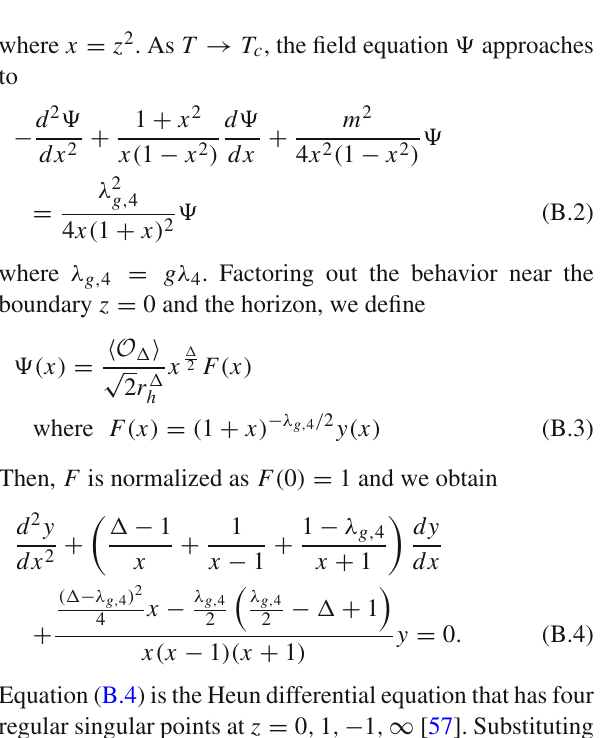
Table 5 ω n and T at lower T ’s. where n = 1 , 2 , 3 ,... . A position of the pole is obtained from Eq. (A.98) with given T T c T c program Poles of σ(ω) ω 1 T = 0 . 1 with ω / T = 10 . 9 10.44 g c T c T = 0 . 05 with ω / T = 13 . 4 11.85 13.11 g c T c T = 0 . 04 with ω / T = 14 . 62 12.19 14.4 g c T c T = 0 . 03 with ω / T = 16 . 34 g c T c T = 0 . 02 with ω / T = 19 . g c T c